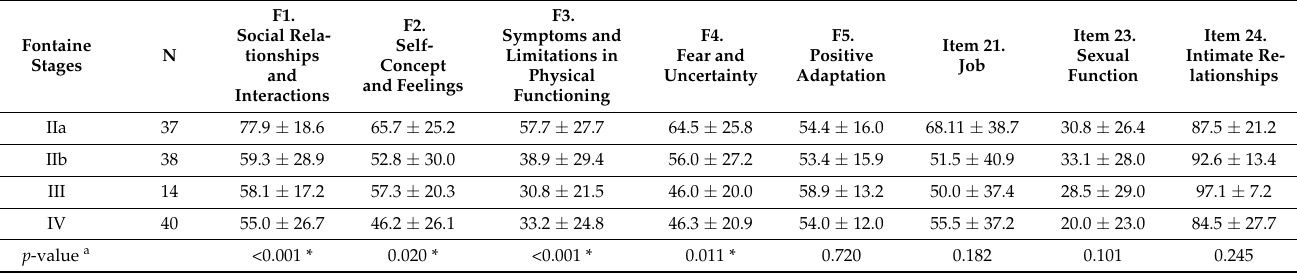
Table 7. The correlation between Fontaine stages and PADQoL factors. Legend: * Asterisked data indicate statistically significant